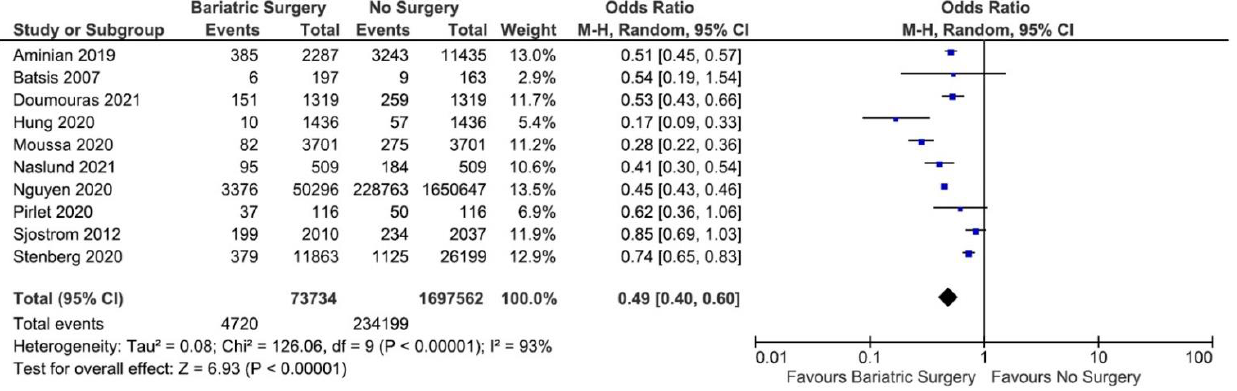
Figure 4. Forest plot of the MACE incidence comparing bariatric surgery with no surgery.